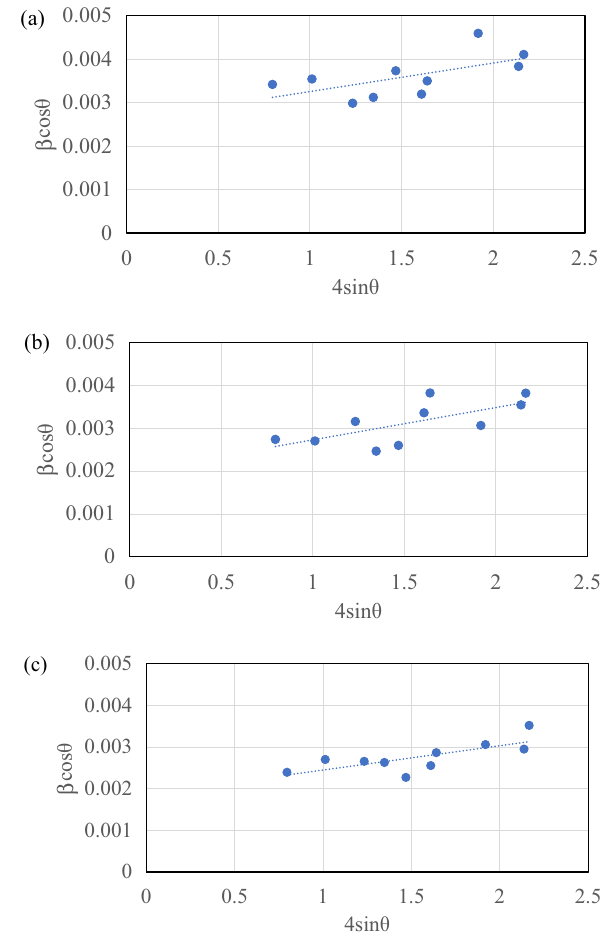
Fig. 4 Williamson-Hall Plots of CaCO TiO /CaCO (X g) photocatalysts; X = a 0.4, b 0.8, and c 4.0 g 2 3